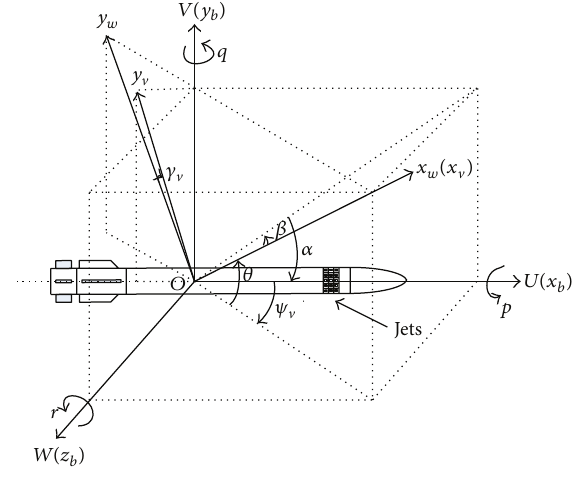
Figure 1: Key coordinate